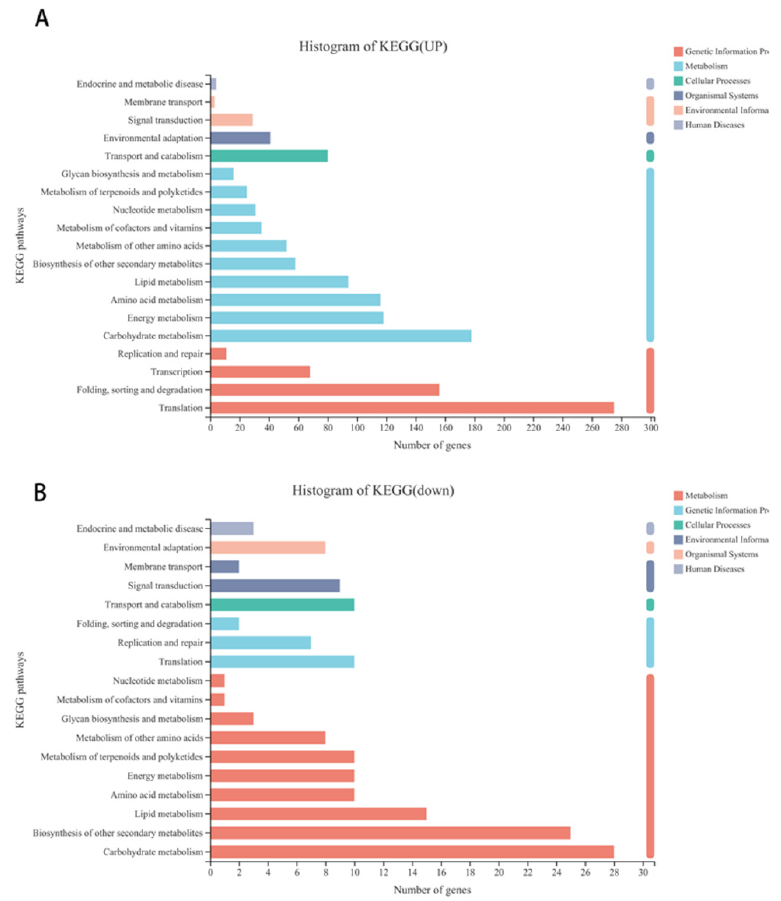
Figure 3. KEGG pathway classification of differentially expressed genes in alfalfa after thrips infection. ( A ) KEGG pathway classification of upregulated differentially expressed genes in alfalfa after thrips infection. ( B ) KEGG pathway classification of downregulated differentially expressed genes in alfalfa after thrips infection.